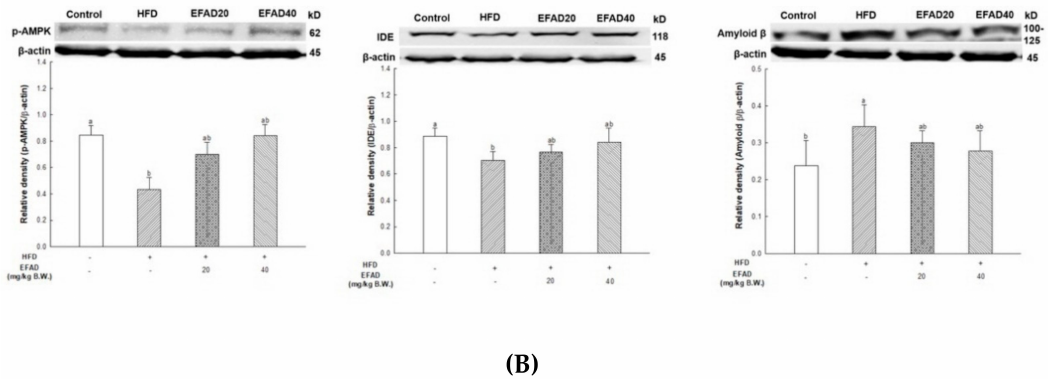
Figure 7. E ff ect of ethyl acetate fraction from Aruncus dioicus var. kamtschaticus (EFAD) against peripheral-insulin resistance induced by HFD. ( A ) Expression degrees of TNF- α and p-IRS(ser307) in white adipose tissue (WAT). ( B ) Expression degrees of TNF- and p-IRS(ser307) in liver tissue. The values shown are as mean ± SD ( n = 3). The data were statistically considered at p < 0.05 and were represented as di ff erent small letters.